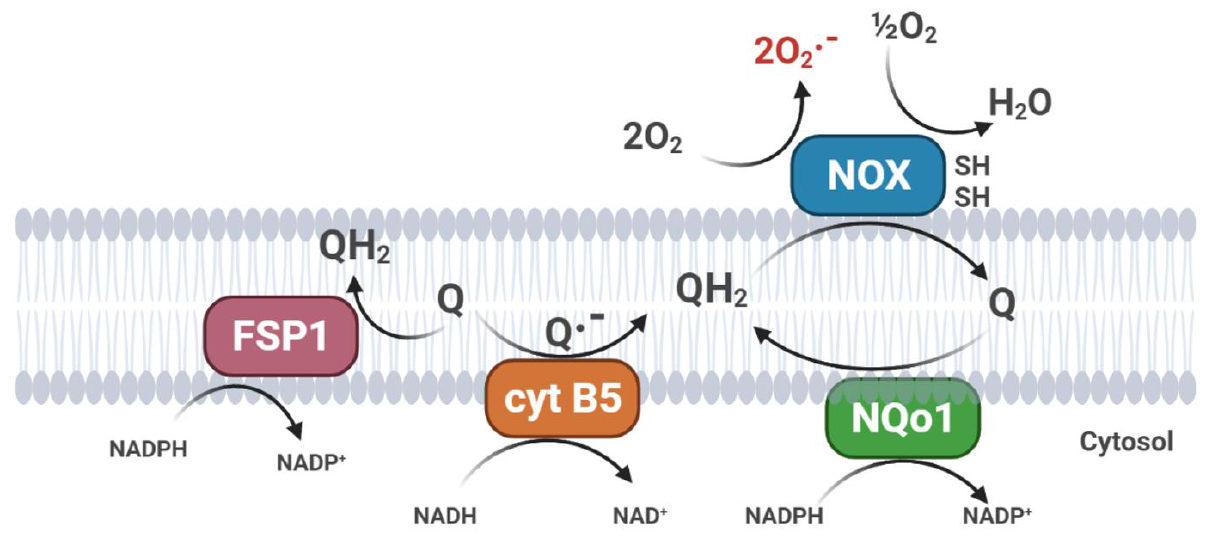
Figure 3. Plasma membrane redox systems (PMRS). (FSP1, Ferroptosis Suppressor Protein 1; cyt B5, cytochrome b5 reductase; NQo1, NAD(P)H: quinone oxidoreductase; NOX, plasma membrane NADH oxidase).